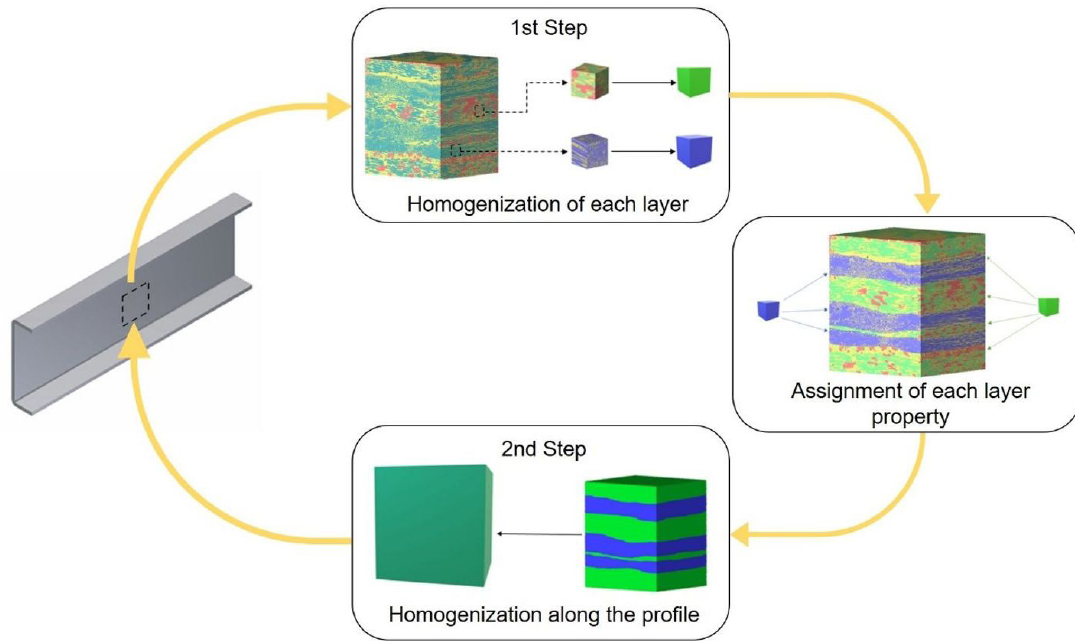
Figure 16. Two-step homogenization methodology.